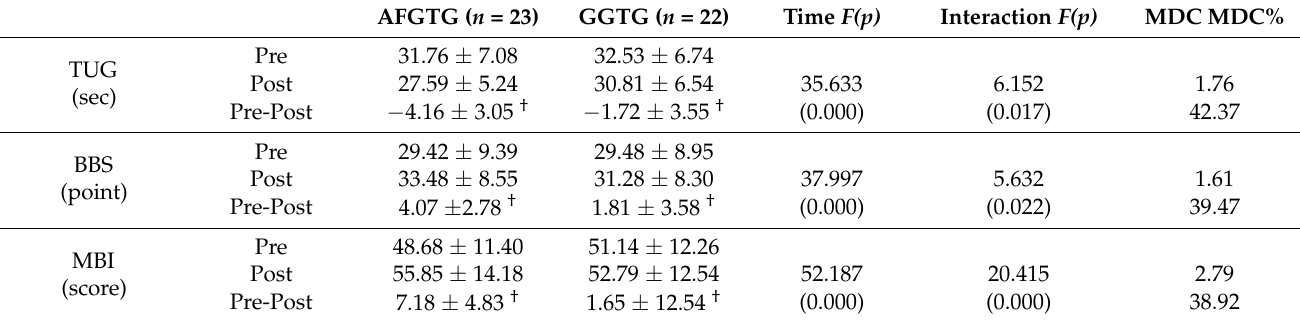
Table 5. Changes in dynamic balance and ADL